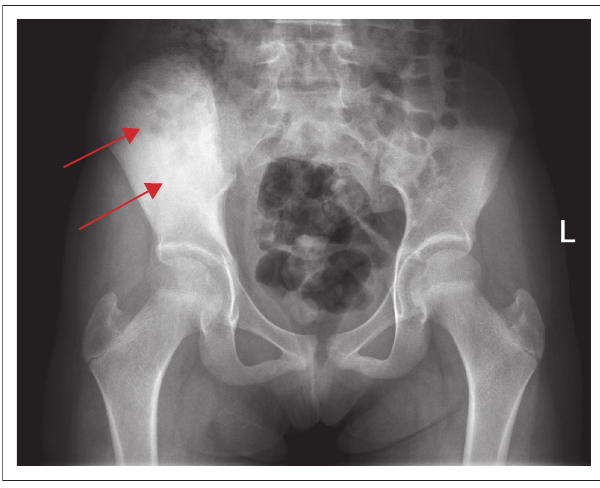
FIGURE 1: An 11-year-old-girl with chronic recurrent multifocal osteomyelitis: Initial plain radiograph of the pelvis demonstrated diffuse sclerosis of the right iliac wing (arrows).